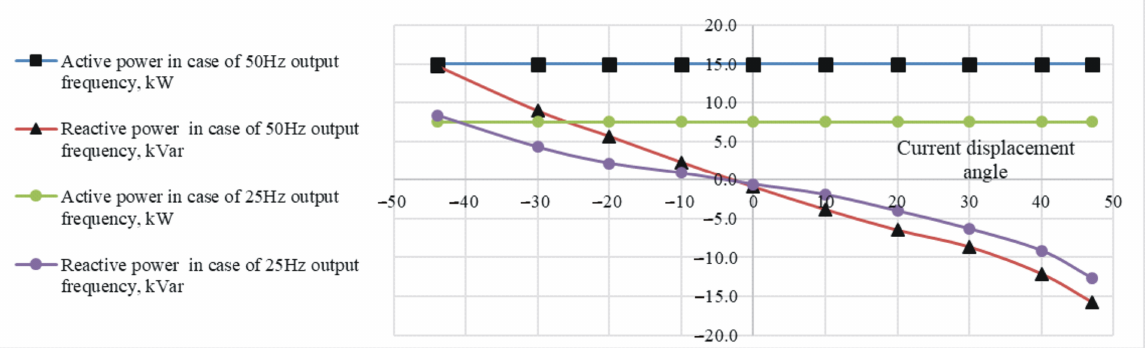
Figure 13. Thereactivepowercompensationrangesofthe15kWMC-basedVFDconnectedto0.4 kV PDL.